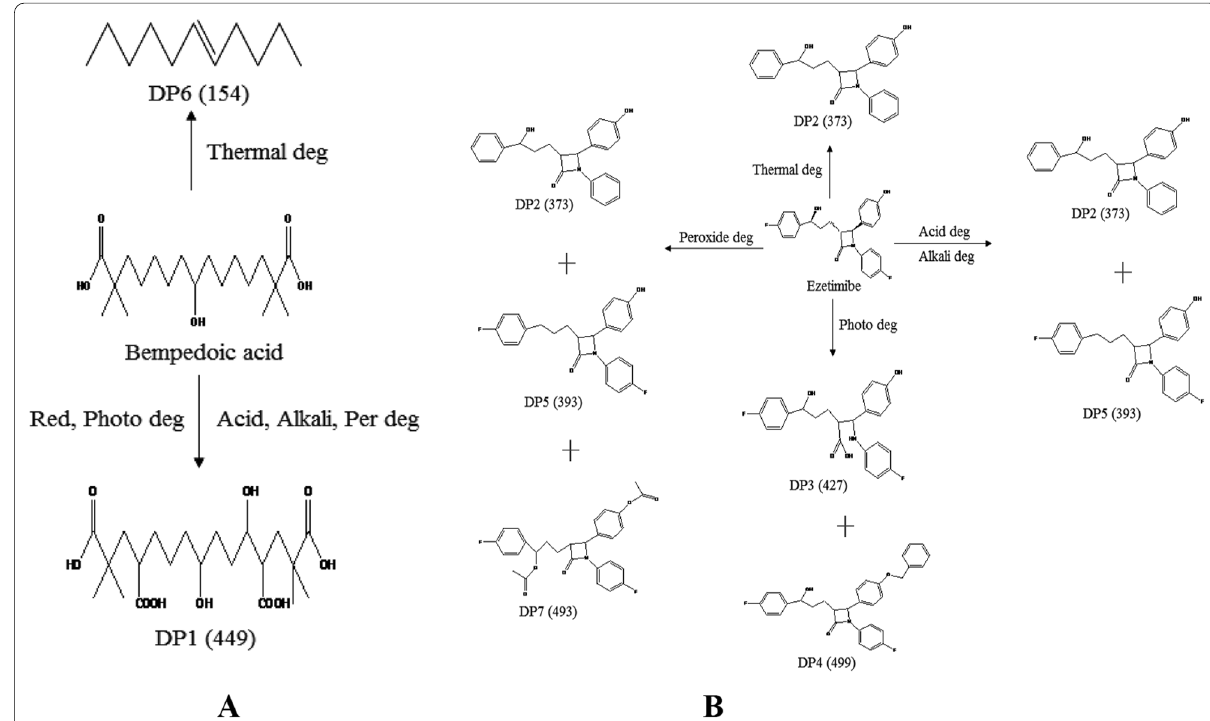
Fig. 1 Schematic representation of degradation products of A Bempedoic acid and B